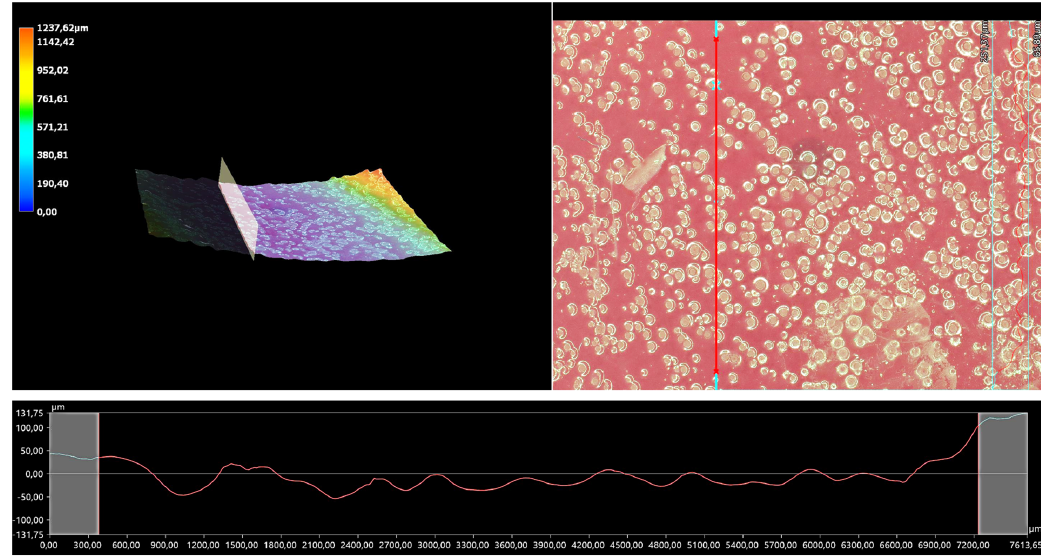
Figure 10. A 3D view of the roughness profile of sample 0.025/Photo.